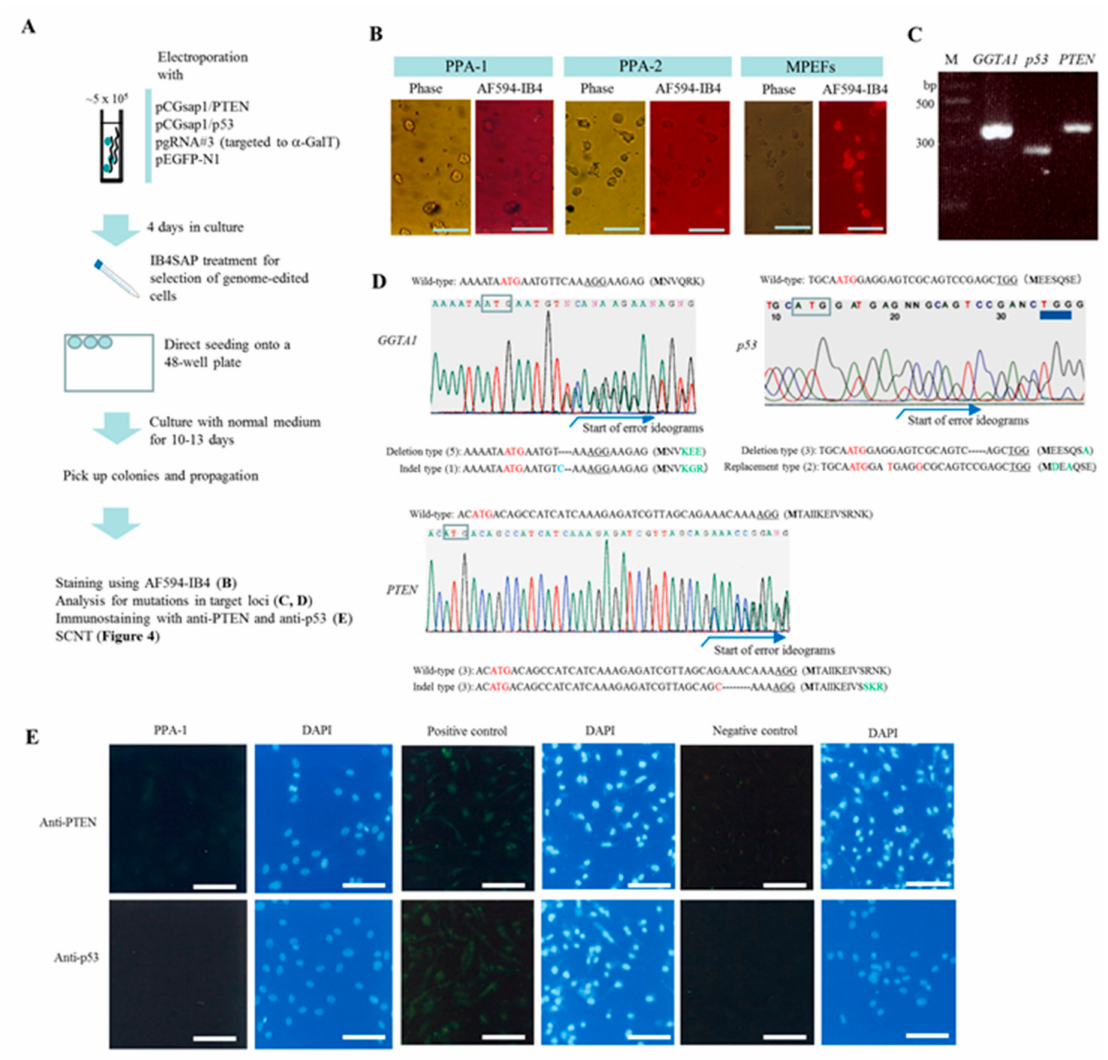
Figure 3. ( A ) Flowchart of the experiments used for testing the feasibility of the new system for the enrichment of cells genome-edited at multiple target loci. Four days after transfection with pCGsap1/PTEN, pCGsap1/p53, pgRNA#3, and pEGFP-N1, cells were treated with IB4SAP for a short period and cultured in normal medium for more than 10 days. The emerging colonies were propagated for molecular biological and cytochemical analyses; ( B ) cytochemical staining of clones PPA-1 and -2 and untransfected MPEFs with AF594-IB4. Phase, photographs taken under light microscopy; AF594-IB4, photographs taken under UV illumination to detect AF594-IB4--derived red fluorescence. Bar = 30 µ m; ( C ) electrophoretic pattern of PCR products derived from the amplification of PPA-1 using primer sets specific to each gene ( GGTA1 , p53 , and PTEN ). M, 100 bp-ladder markers; ( D ) direct sequencing of PCR products from PPA-1 using primers specific to PTEN , p53 , or GGTA1 gene. In the bottom of each ideogram, sequencing results of inserts sub-cloned into TA cloning vector are shown. The numbers of clones examined are shown in parentheses. The start codon ATG is shown by boxes or in red. PAM is indicated by underlines. The deleted portion in the clones is shown by dotted lines; ( E ) immunocytochemistry of PPA-1 using anti-PTEN and anti-p53 antibodies. The parental MPEFs are used as positive control. The parental MPEFs reactive to the second antibody (fluorescein-labeled goat anti-rabbit IgG) alone are designated as negative control. All cells were counterstained with DAPI upon reaction with the second antibody. Bar = 30 µ